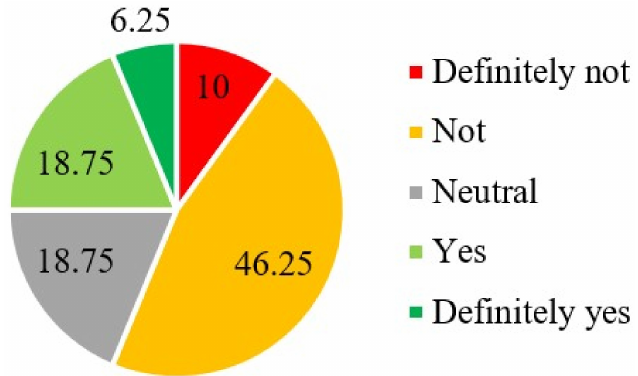
Figure 7. Willingness to participate in social debate to block the development (%). Source: based on own